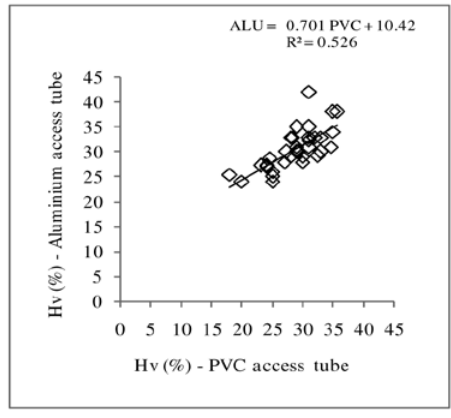
Fig. 3 - Relationship between H (%) measurements made simultanu- v ously with the aluminium and PVC-polyamide access tubes.